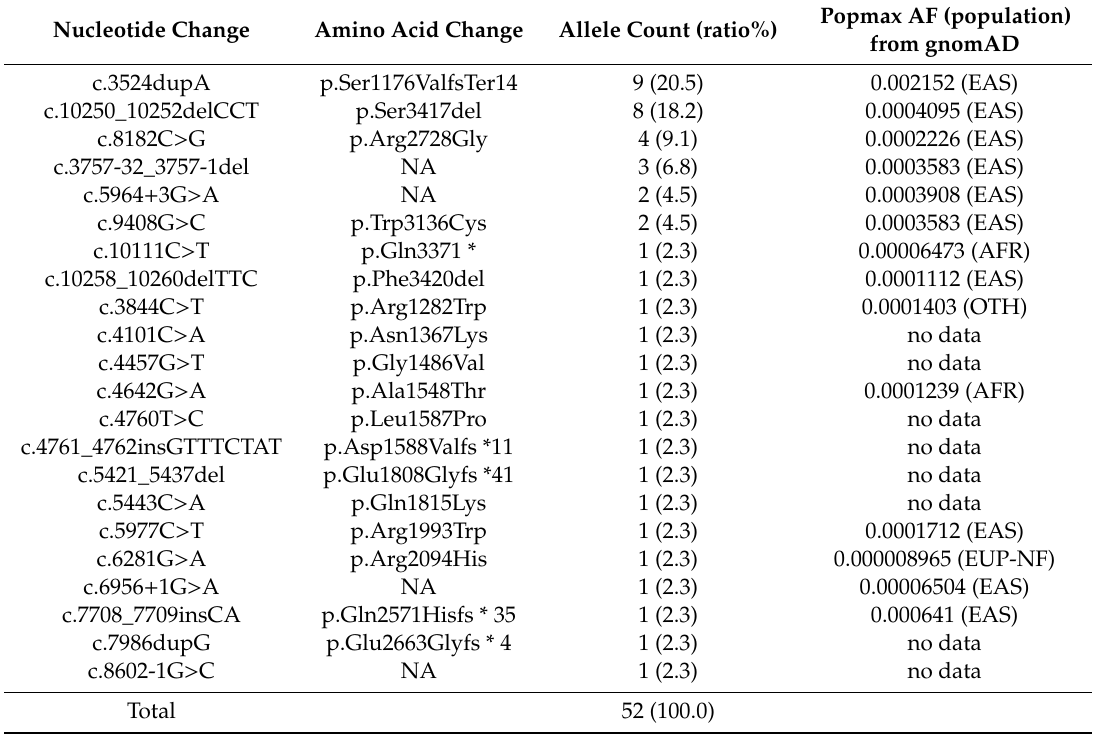
Table 5. MYO15A mutations detected in Taiwanese